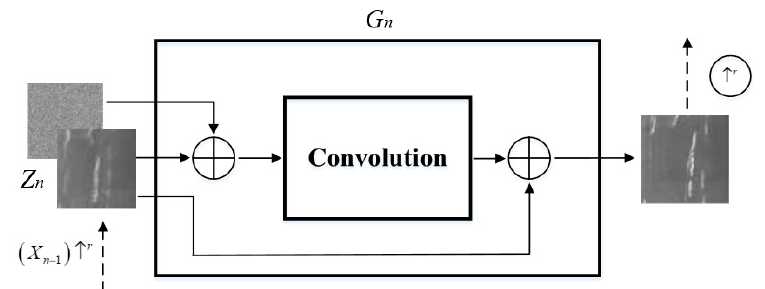
Figure 3. The structure of the generator. The discriminator consists of fi ve simple convolution layers. After the image distri- bution at the current scale is obtained through the sampling method, the image data ob- tained from the last stage and current stage will be input into the discriminator to calculate the loss function. 3.1.1. Image Size Adjustment As is mentioned above, the model in the early training stage focuses mainly on the learning of the overall structural layout of images. In the later training stage, it focuses on the learning of texture details of images. Due to the great uncertainty of the structure, texture details and defect color are taken mainly as standards of defect classi fi cation. Therefore, the texture and details should be considered, and the structure and layout should be less focused on. In the process of training, the model needs to use multiple re- constructed images with di ff erent resolutions. The number of images with di ff erent reso- lutions depends on the number of stages during the process of training. The generation of natural landscape samples in ConSinGAN requires a speci fi c global image layout and learning in low-resolution stages. As defect images require more high-resolution stage learning, we design a curve function to adjust the image size scaling, as is shown in (4):